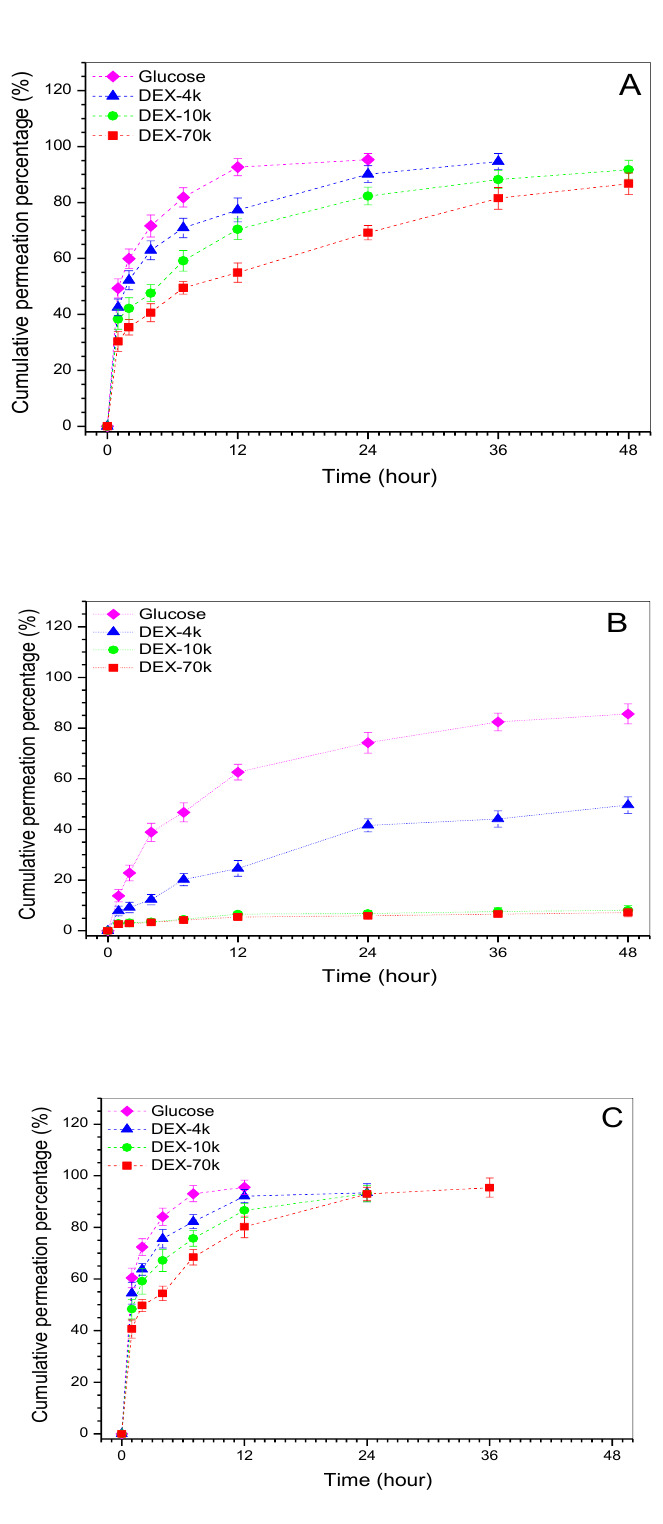
Figure 4. Time-dependent sheet permeation of different model molecules correspond to chondral layer ( A ); mimetic calcified layer ( B ); and, bony layer ( C ), respectively, (see Figure 3A for the name of